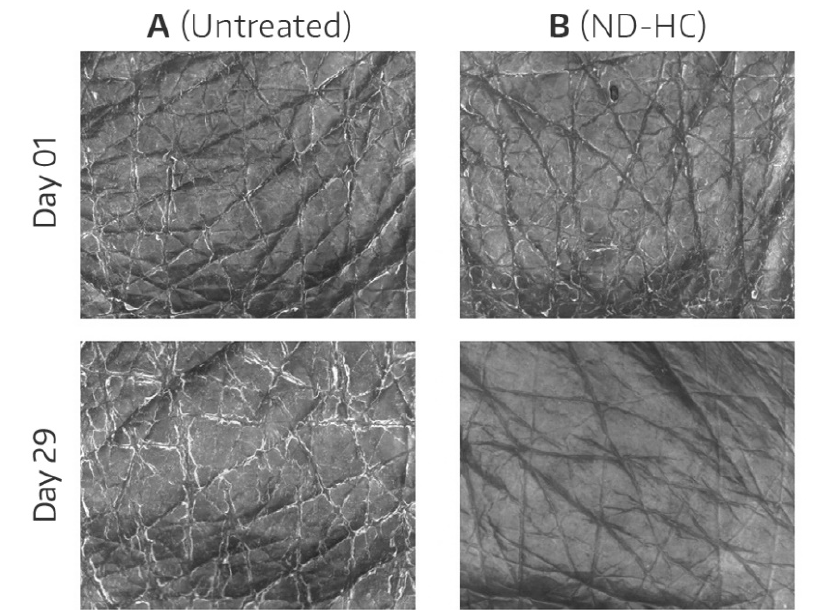
Figure 2. Representative Visioscan ® VC 20 plus images of a skin area at baseline and after 4 weeks’